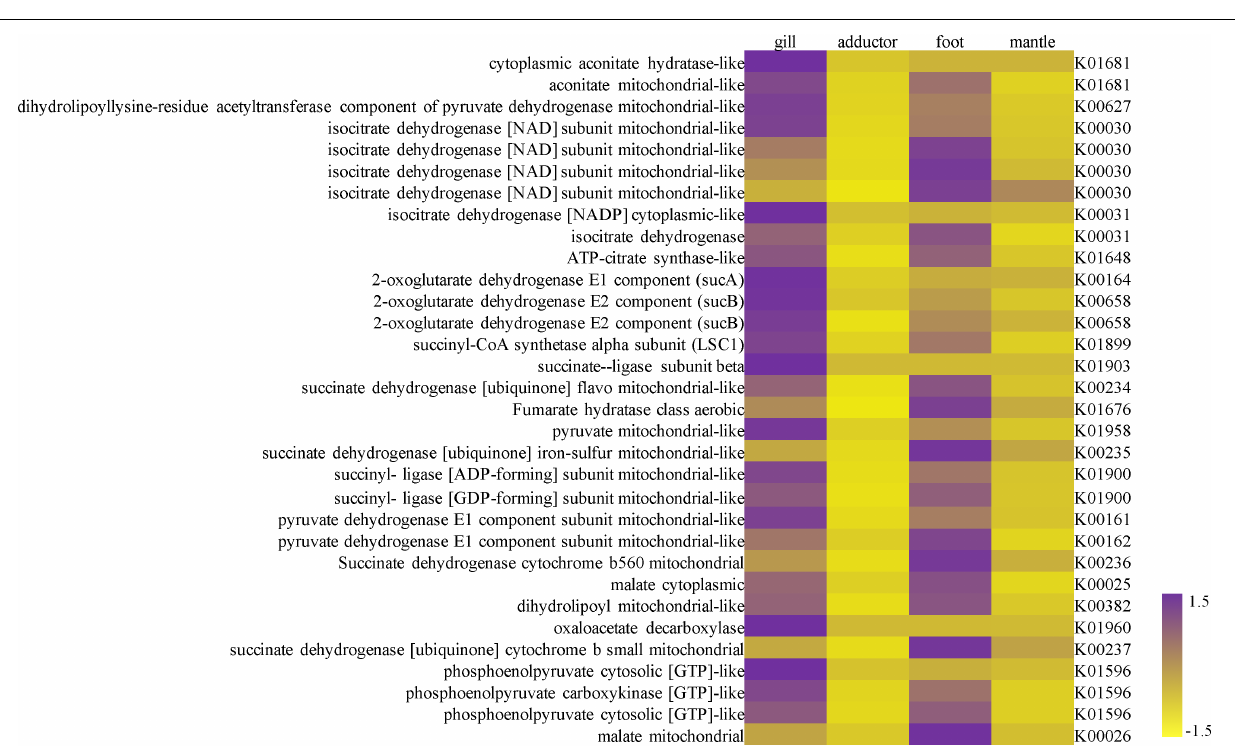
FIGURE 2 | A heat map showing the expression level of genes in the TCA cycle in the gill, adductor muscle, foot, and mantle of Archivesica marissinica (left: NR annotation; right: KEGG